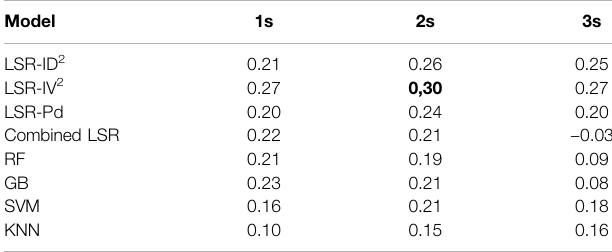
TABLE 9 | R 2 scores for US dataset corrected drift